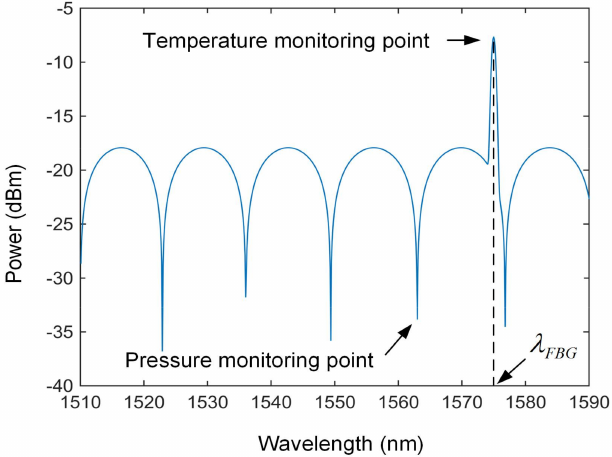
Figure 2. Interference spectrum simulation of the fiber-optic FP gas pressure